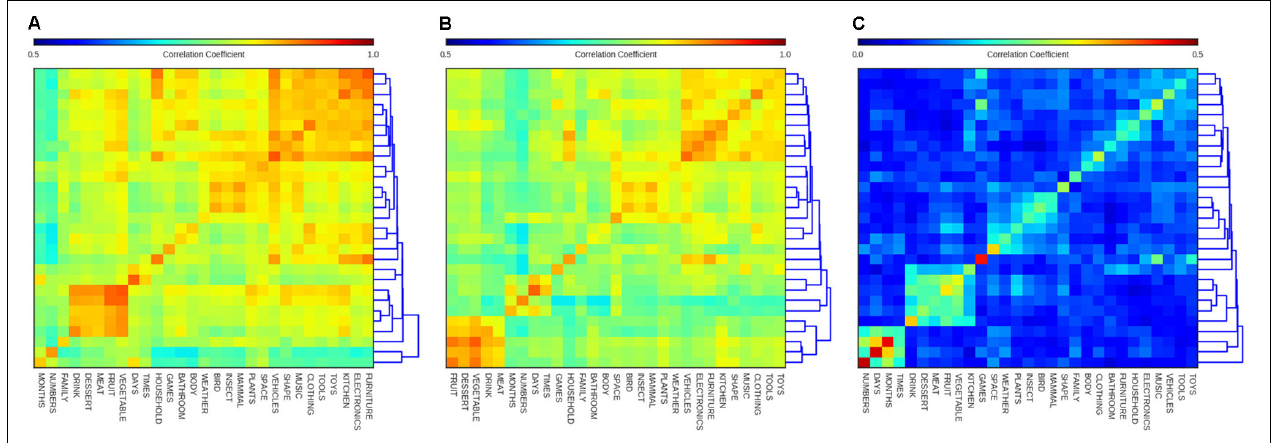
FIGURE 5 | Dendrogram heatmap diagrams showing the average similarity of words (i.e., the Pearson correlations of the words’ hidden state activations) within and between categories for (A) SRN, (B) LSTM, and (C) Skip-gram. Row ordering mirrors that of columns. Note color scale is different for